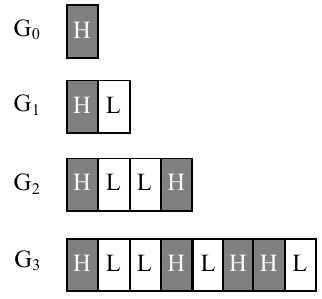
Figure 1: Generation of the Thue-Morse